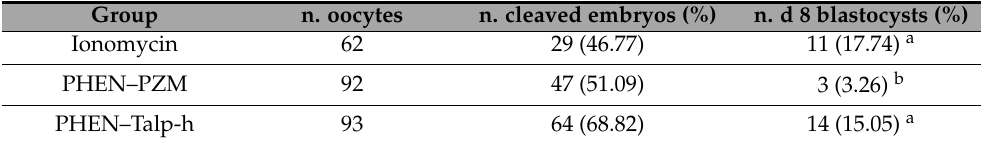
Table 2. In vitro preimplantation development of parthenogenetic porcine embryos using Zn chelator PHEN at 0.5 mM for 1 h in two different media.